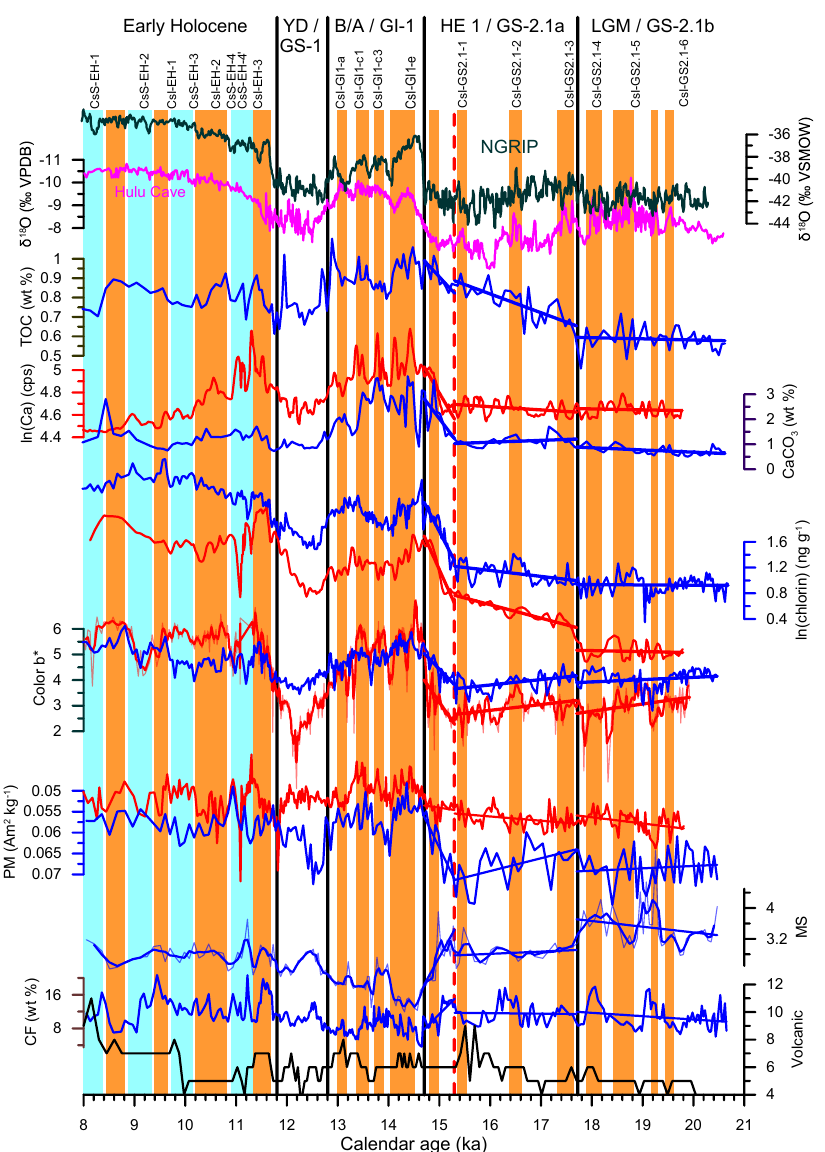
Figure 4. High-resolution variability in the productivity and lithologic proxies in the NW Pacific during 21–8ka. Volcanic particles, CF, MS, PM, color b ∗ , chlorin, CaCO 3 /Ca, and TOC determined in cores 41-2 (blue lines) and 12KL (red lines) are shown from bottom to top. (cid:49) 18 O records of EASM (Wang et al., 2008) and NGRIP (North Greenland Ice Core Project members, 2004) are shown at the top of the figure. Linear trends are shown for productivity and lithologic proxies during 20–17.8, 17.8–15.3, and 15.3–14.7ka periods. The red dashed line marks the boundary in productivity and lithologic trends during HE1 at 15.3ka. Orange and blue bars are as in Fig. 2.